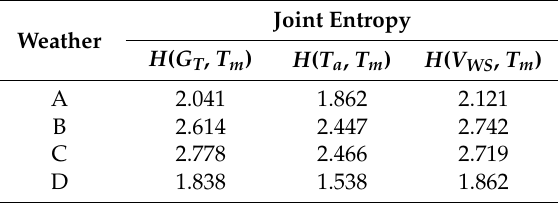
Table 8. The joint entropy in four